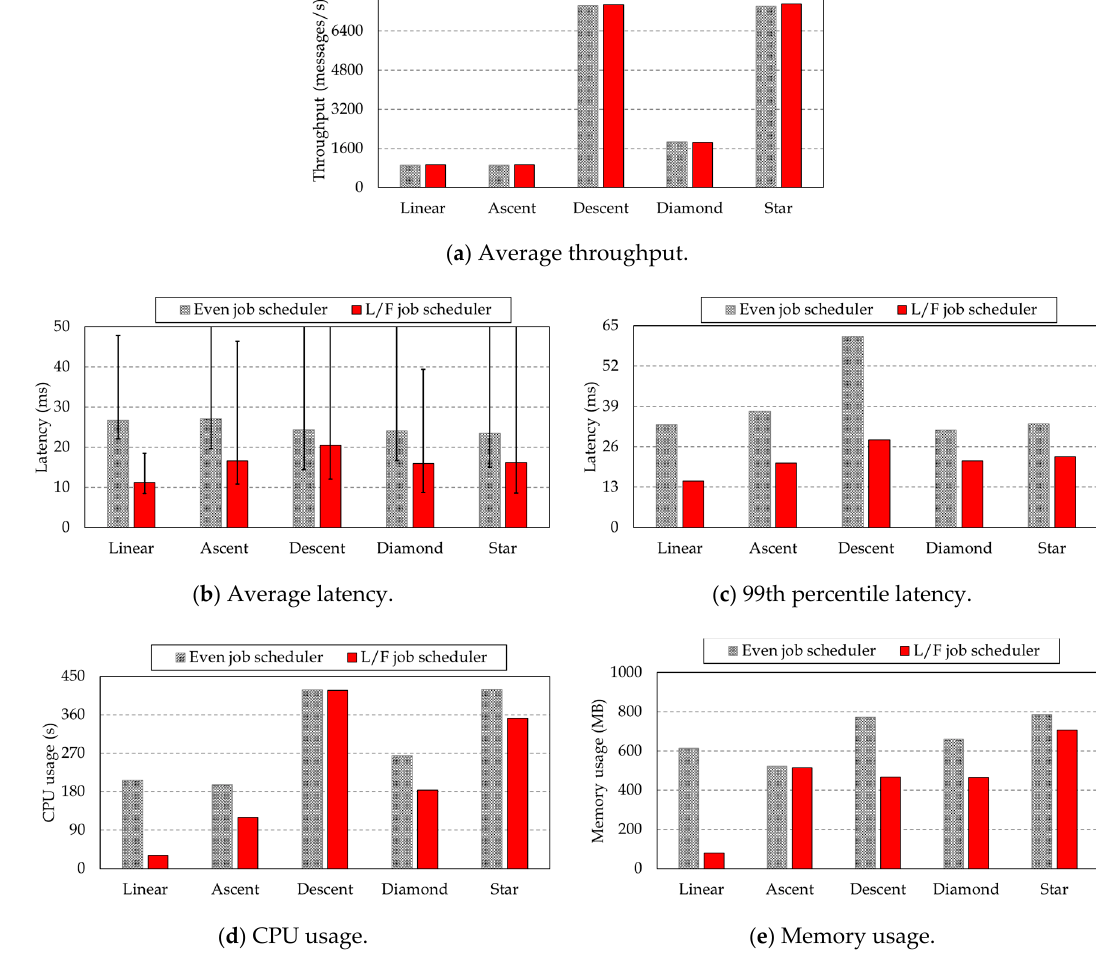
Figure 7. Performance of even and L/F job schedulers with LSP applications in low parallelism.